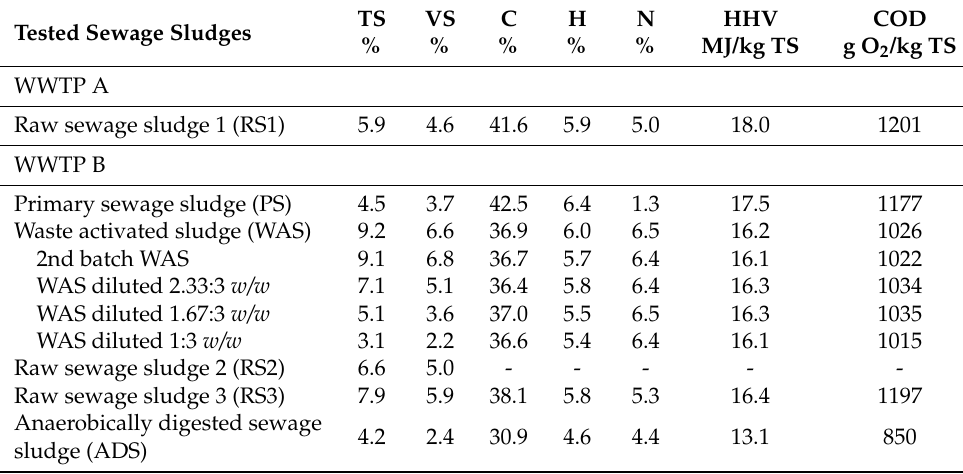
Table 1. Overview of the tested sewage sludges. The spread of the measuring values was evaluated using the mean value and the deviation of each measured value to the mean value. The maximum deviations are ± 7.1% for TS, ± 8.6% for TS, ± 0.7% for C, ± 2.2% for H, ± 2.1% for N, ± 0.8% for COD and ± 1.5% for